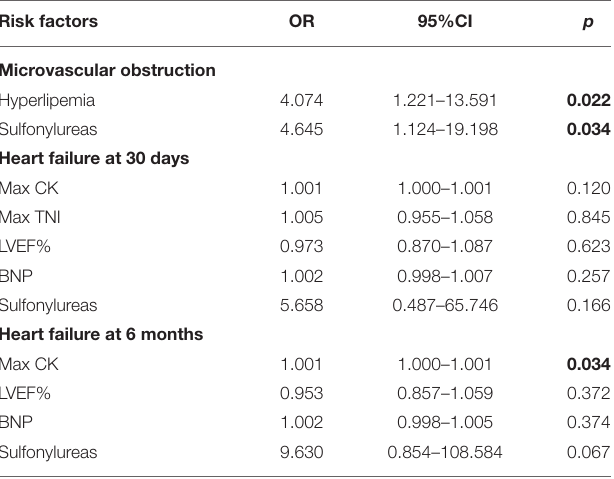
TABLE 5 | Risk factors associated with microvascular obstruction and heart failure assessed by multiple logistic regression